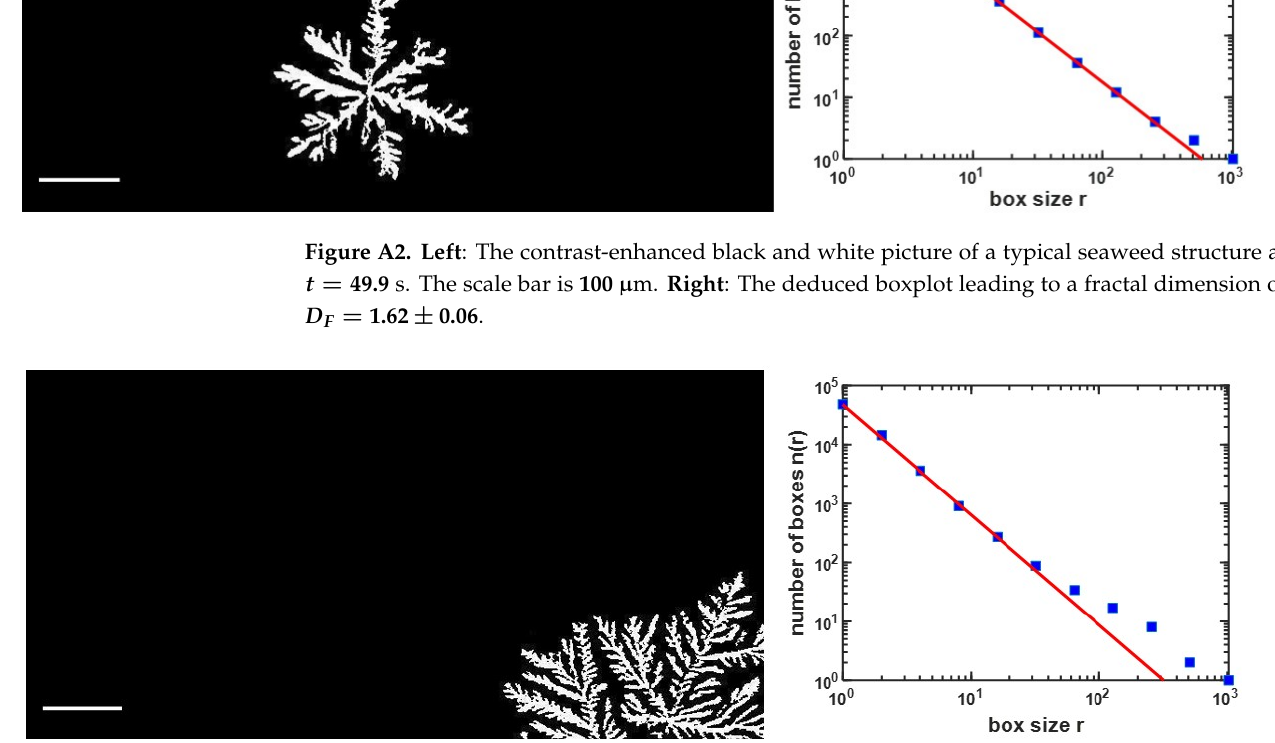
Figure A3. Left : The contrast-enhanced black and white picture of a typical dendrite at t = 8.3 s. The scale bar is 100 µ m. Right : The deduced double logarithmic boxplot leading to a fractal dimension of D F = 1.87 ± 0.15